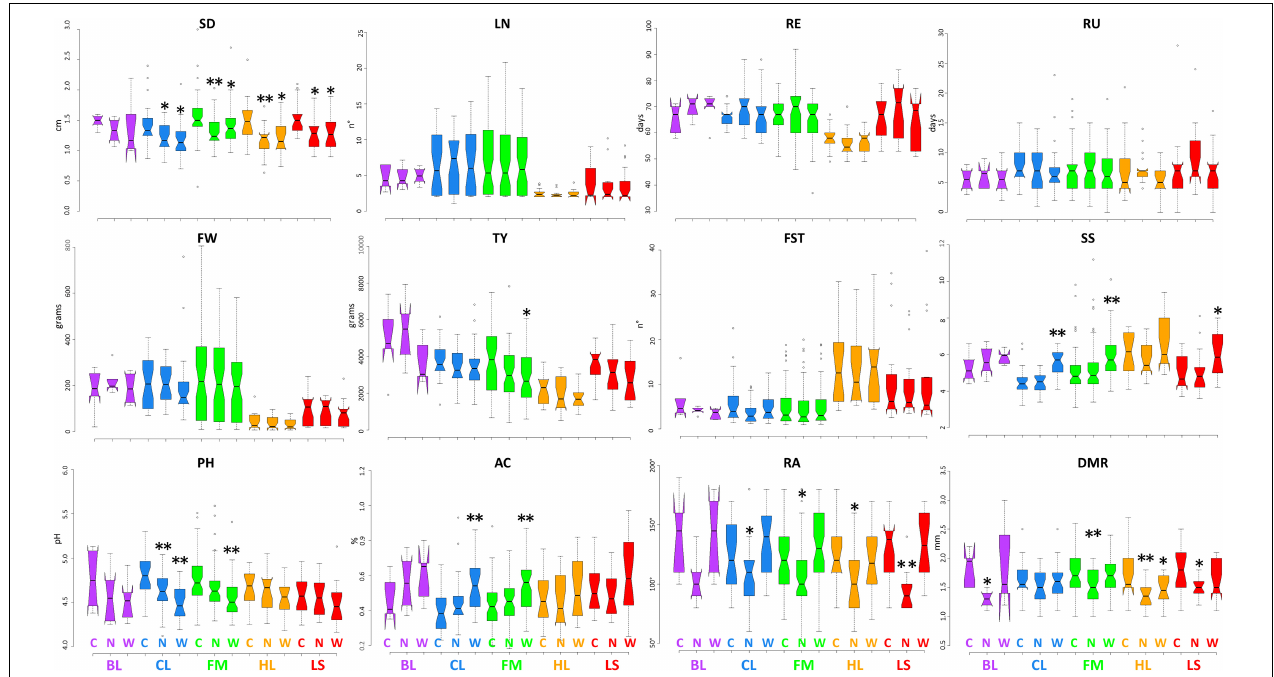
FIGURE 3 | Variation for quantitative traits in the five cultivar groups grown under control and stress conditions in Spain. Notched boxplots showing median values and quartiles for the five considered cultivar groups grown in Spain under control (C), water deficit (W), and nitrogen stress (N). The measurement scale for each trait is reported on the Y-axis; details in Table 2 . The asterisks indicate significant differences with respect to the control condition according to the Dunnett’s test; the single ( ∗ ) and the double ( ∗∗ ) asterisk indicates p < 0.05 and p < 0.01, respectively. BL = breeding lines, CL = elite cultivars, FM = landraces for the fresh market, HL = heirlooms, LS = long shelf-life